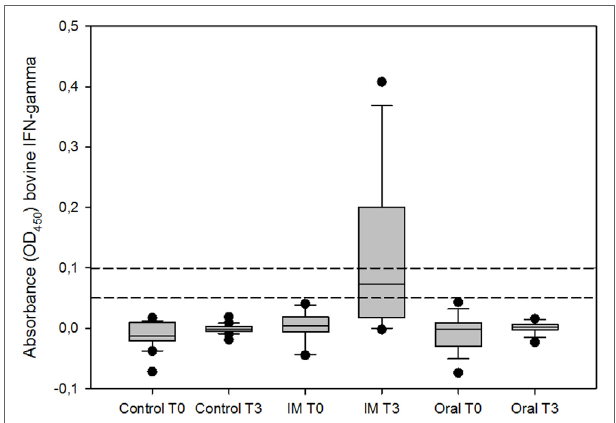
FigUre 2 | IFN- γ response of whole blood stimulated with bovine purified protein derivative (PPD), expressed as optical density (OD 450 ). T0 represents the day of prime vaccination and T3 3 months later. Boxes represent the lower, median, and higher quartile ranges and “outliers” are represented by closed circles. The dashed lines represent the cutoff values used in this study (0.05 and